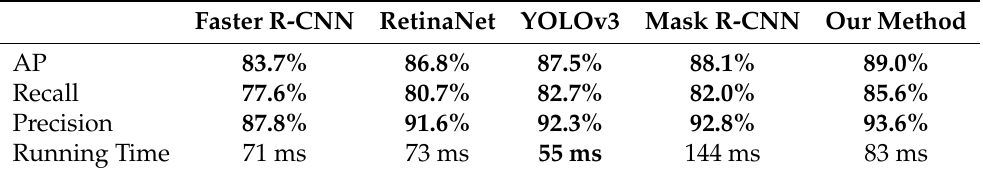
Figure 13. Some failed cases of the proposed method. The missed detections are marked by green boxes. Table 4. Quantitative comparison results on real remote sensing data.